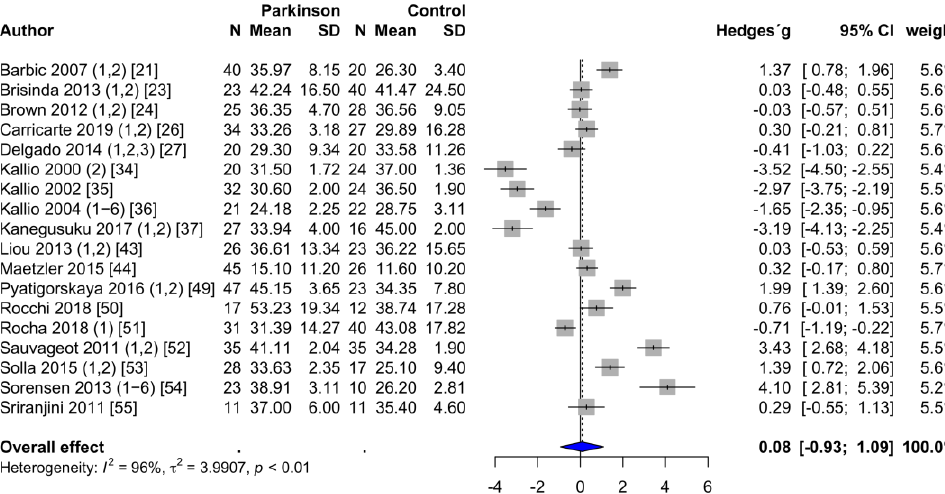
Figure 3. Forest plot HFnu, random-effects meta-analysis. HFnu: High-frequency components of the power spectral density in normalized units.